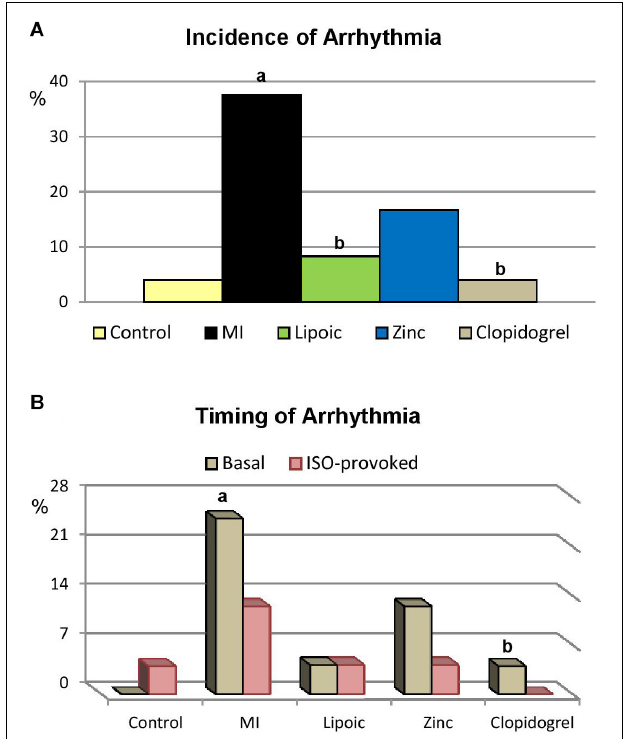
FIGURE 4 | Arrhythmia in the control, untreated myocardial infarction (MI) and pre-treated (lipoic acid, zinc sulfate and clopidogrel) groups. Significance of differences is calculated by χ 2 -test at p < 0.05; a—vs. controls, b—vs. MI group; (A) incidence of total arrhythmia, (B) incidence of each type of the observed arrhythmia; whether at basal condition (Basal) or induced by ISO infusion